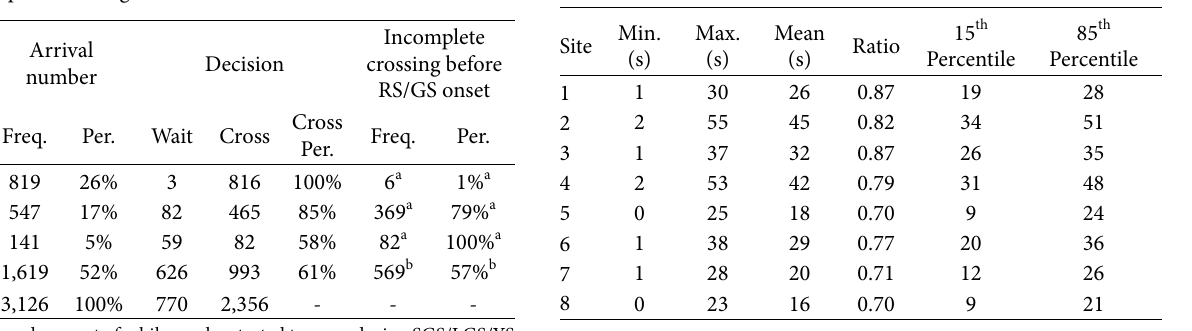
Table 4: Time left to the RS onset.